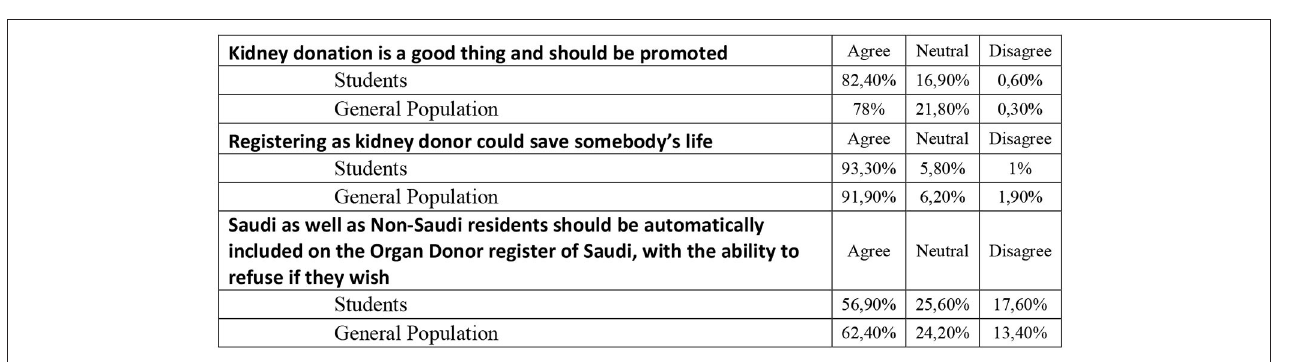
FIGURE 6 | Value perception of kidney